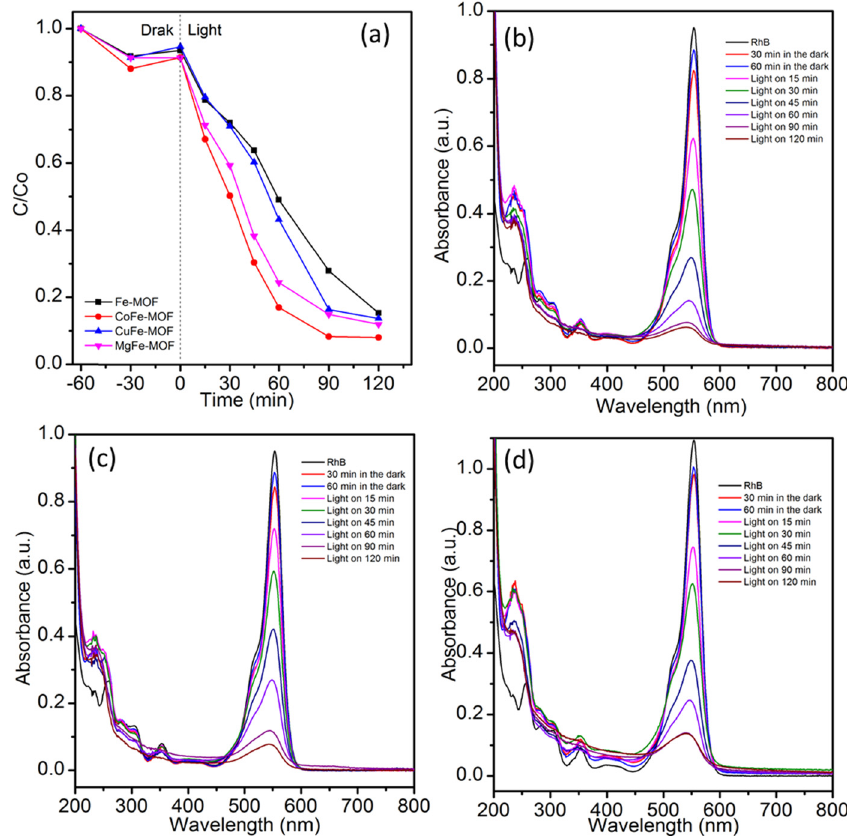
Figure 6: ( a ) Photodegradation of RhB, ( b ) UV - Vis spectral of RhB of Co/Fe - MOF, ( c ) Cu/Fe - MOF, and ( d ) và Mg/Fe -